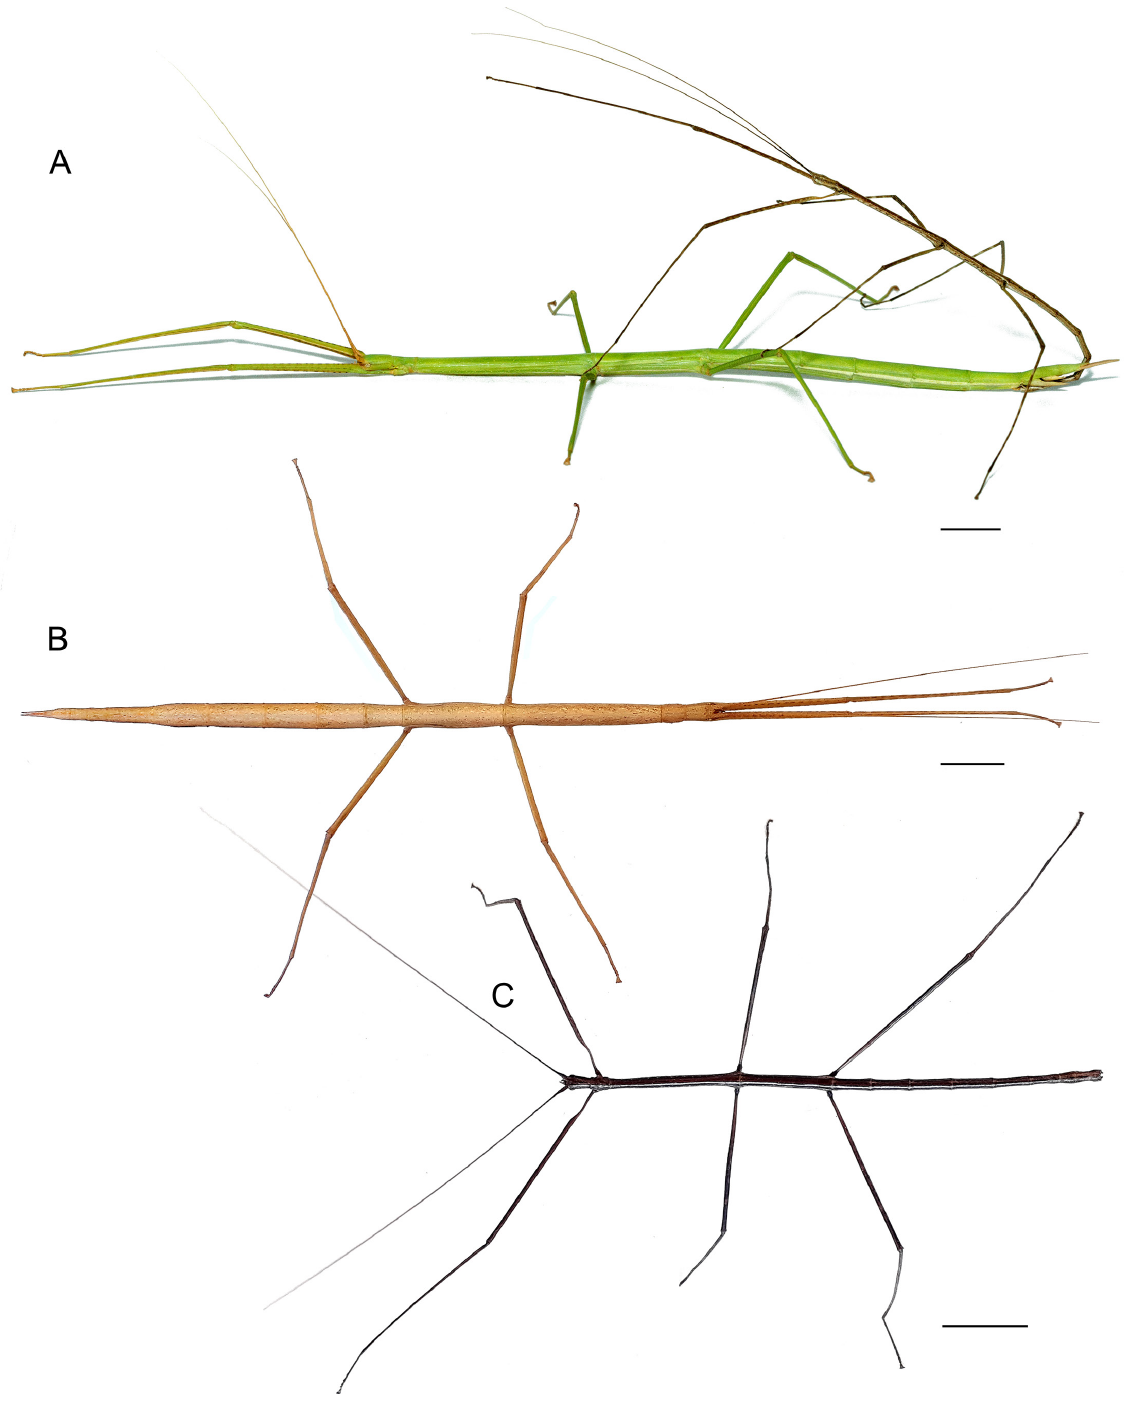
Fig. 34. Live habitus of Arumatia motenata Ghirotto gen. et sp. nov. from Serra do Cipó, Minas Gerais, Brazil. A . Mating pair. B . Adult ♀, holotype (MZUSP V0603). C . Adult ♂. Scale bars: 1